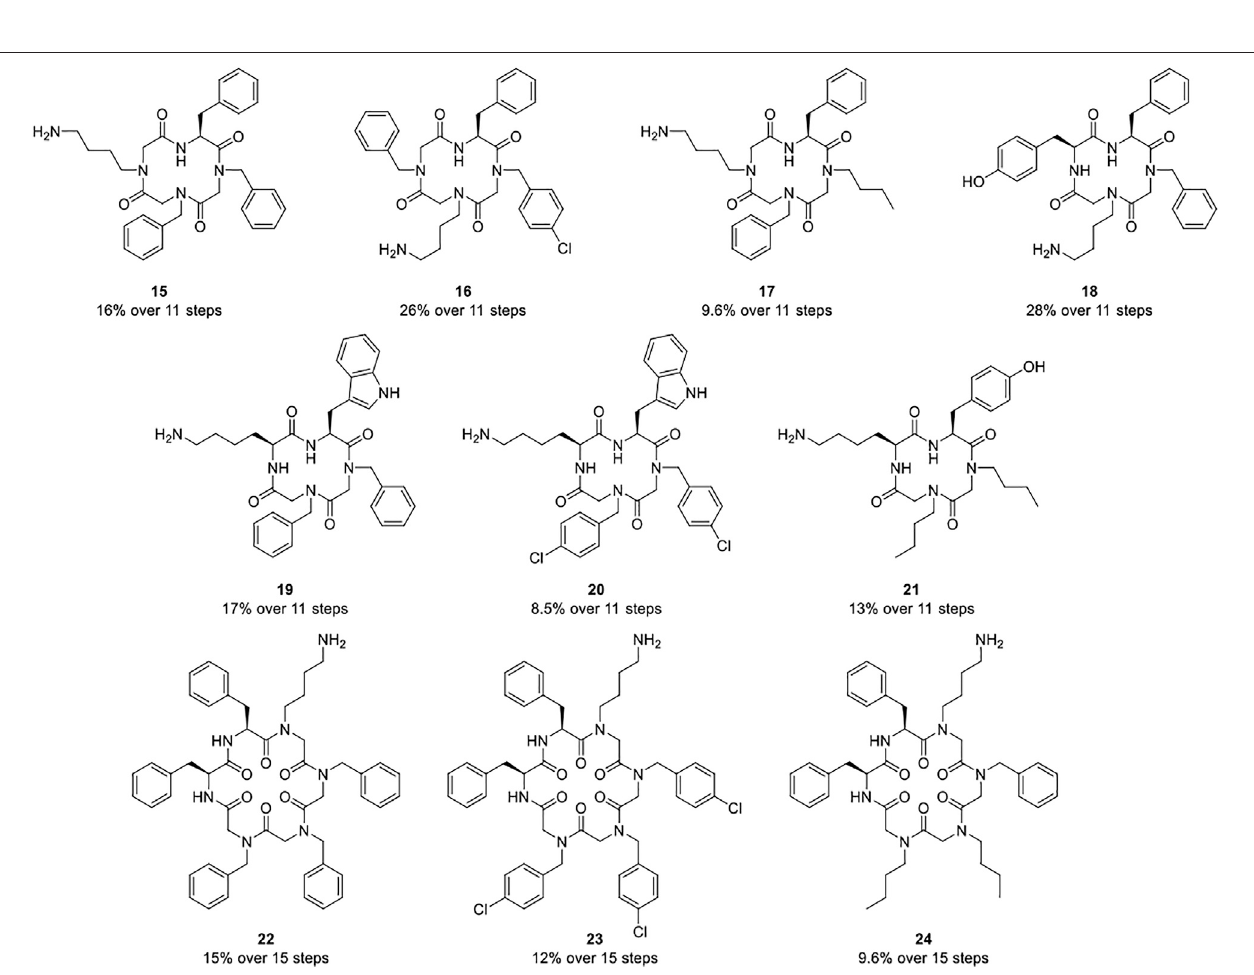
FIGURE 3 | Macrocyclic hybrids 15 – 24 composed of alkylated glycine monomers and amino acids that were assembled via a combination of solid and solution phase methods.